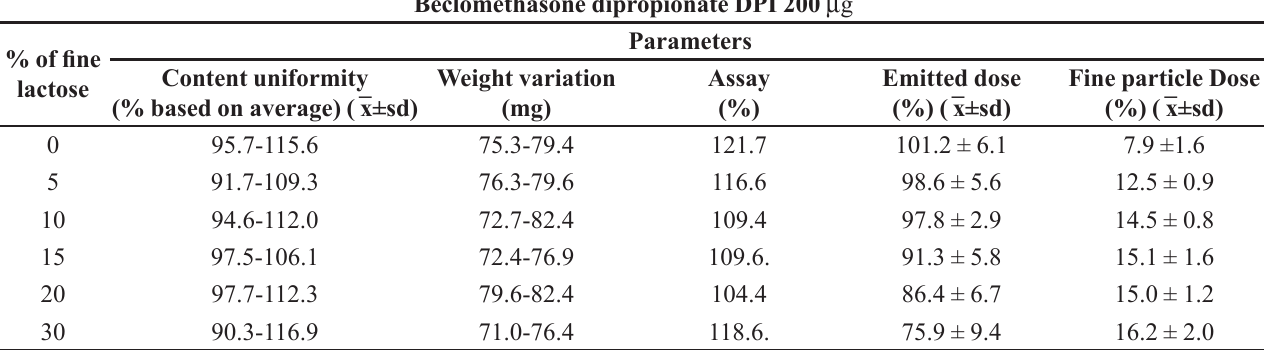
TABLE II - Characterization of DPI formulation with various portions of fine